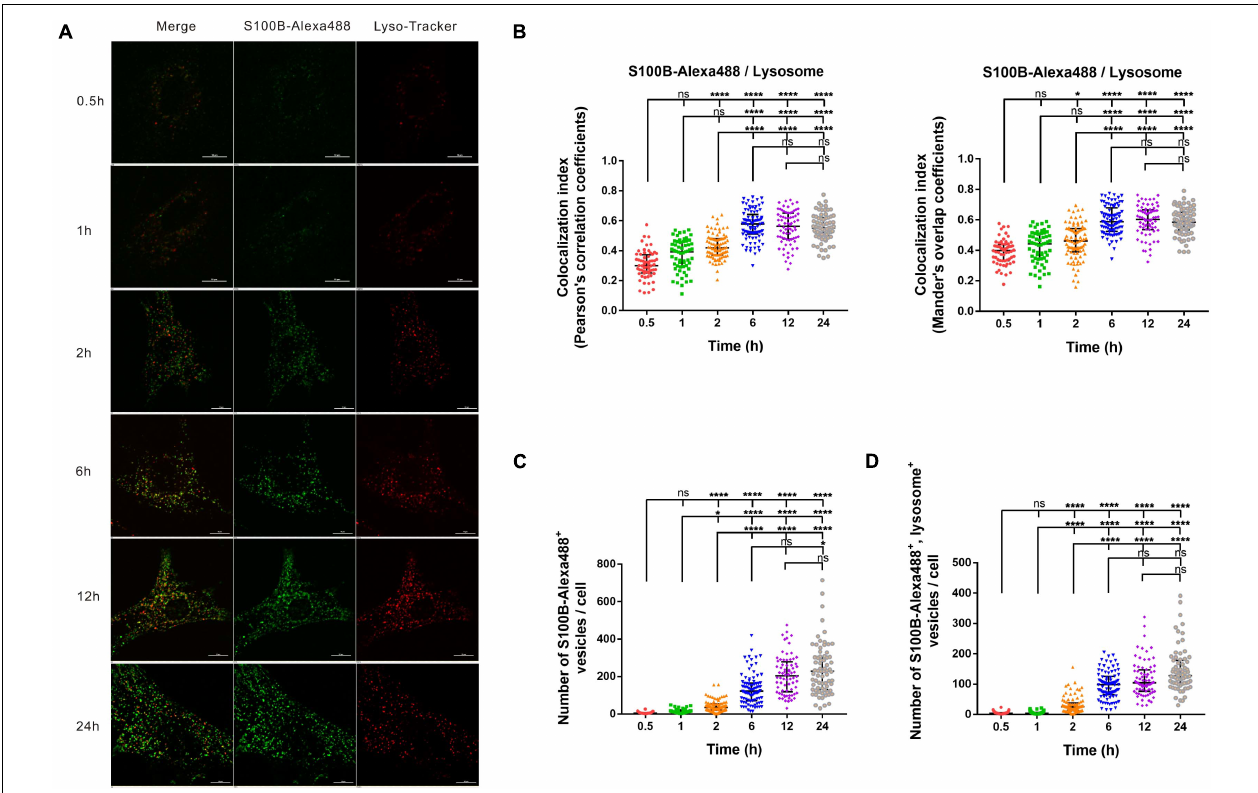
FIGURE 4 | The intracellular transportation and accumulation of S100B-Alexa488 in lysosomes. MSCs were incubated with S100B-Alexa488 (0.1 µ M) for the indicated time periods and stained with Lyso-Tracker Red for 30 min. (A) Representative live cell confocal images. Scale bar, 10 µ m. (B–D) Quantified data (analyzed as described in section “Materials and Methods”) of the indicated time points showing (B) the colocalization index (the Pearson’s correlation coefficients and the Mander’s overlap coefficients) of S100B-Alexa488 and Lyso-Tracker-labeled lysosomes, (C) the number of S100B-Alexa488-positive vesicles, and (D) the number of S100B-Alexa488-positive vesicles colocalized with lysosomes. Data are presented as the median and interquartile range (IQR), n (0.5 h) = 64 cells; n (1 h) = 60 cells; n (2 h) = 87 cells; n (6 h) = 88 cells; n (12 h) = 72 cells; n (24 h) = 71 cells. All the experiments were repeated for three times. Asterisks indicate statistical significance between the indicated groups: * P < 0.05, ** P < 0.01, **** P < 0.0001, ns, not